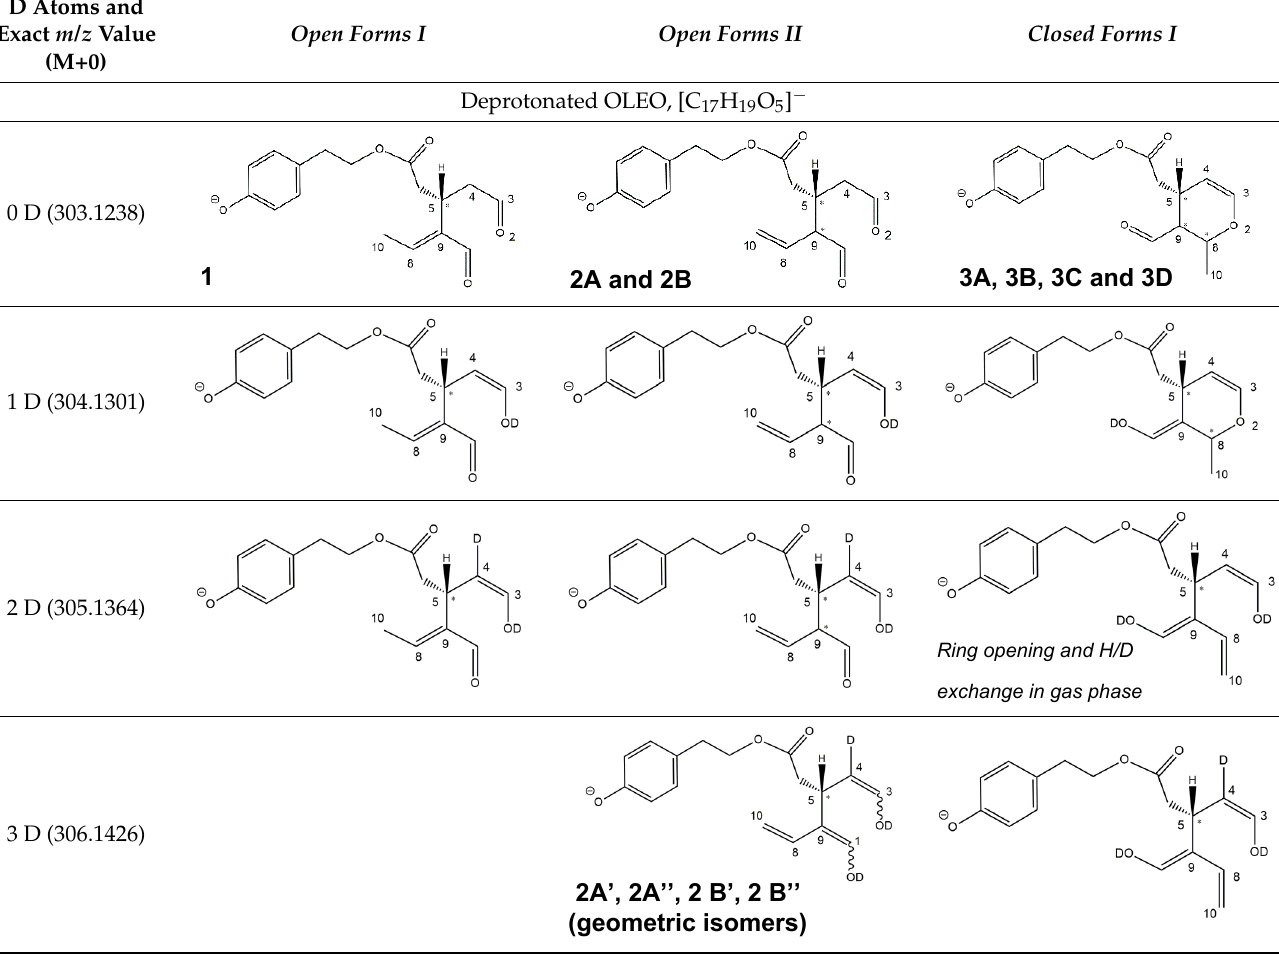
2A and 2B 2A and 2B